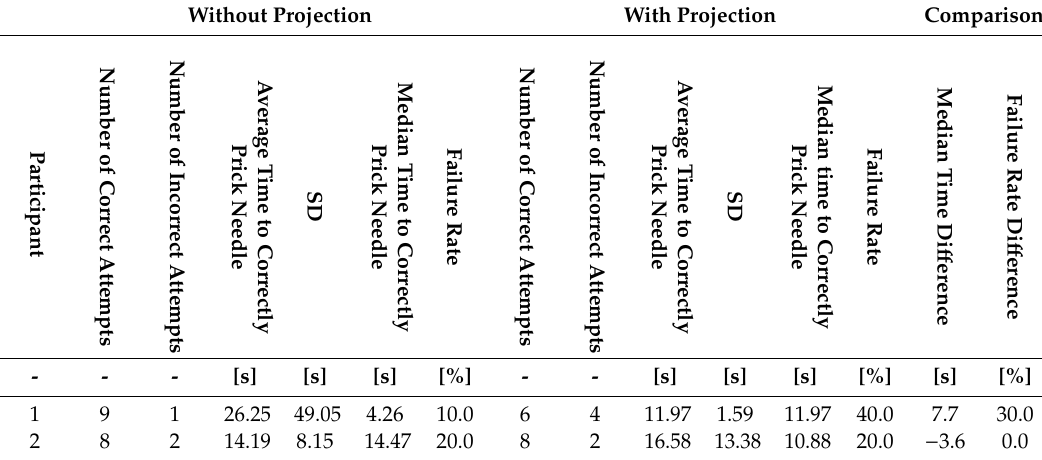
Table 4. MARVIS validation